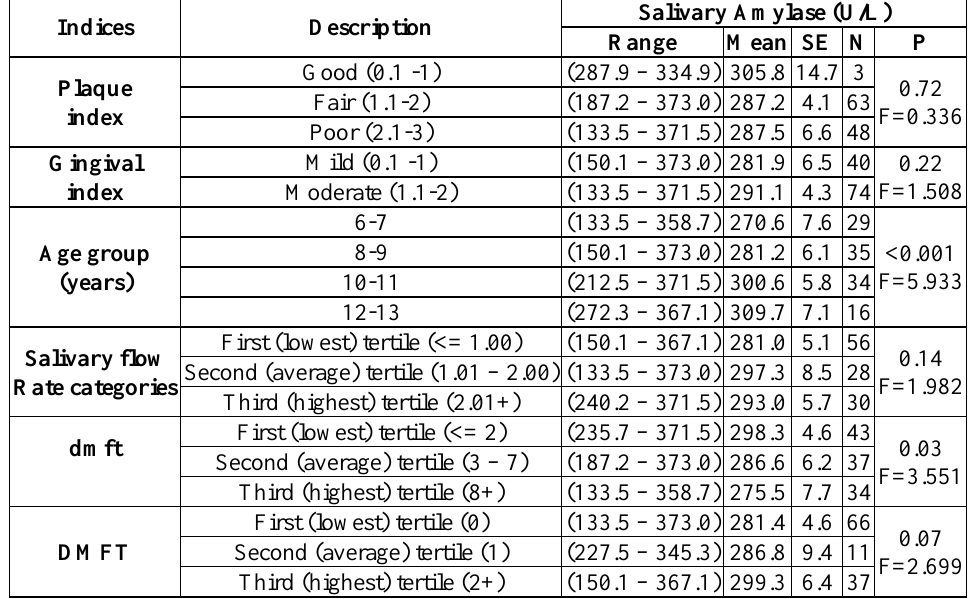
Table 1: Age and oral health status parameters in relation to salivary alpha-amylase